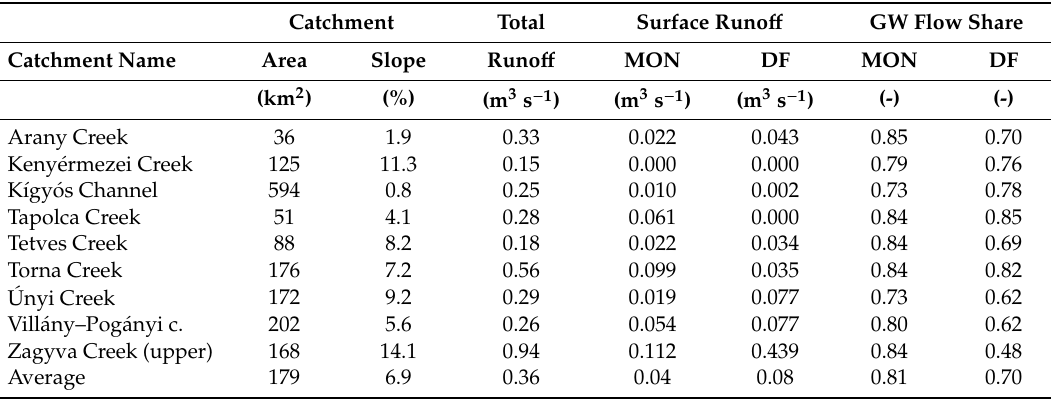
Table 4. Comparison of surface runoff and baseflow index values calculated for gauged catchments as determined by the MONERIS (MON) and the digital filter (DF) methods.